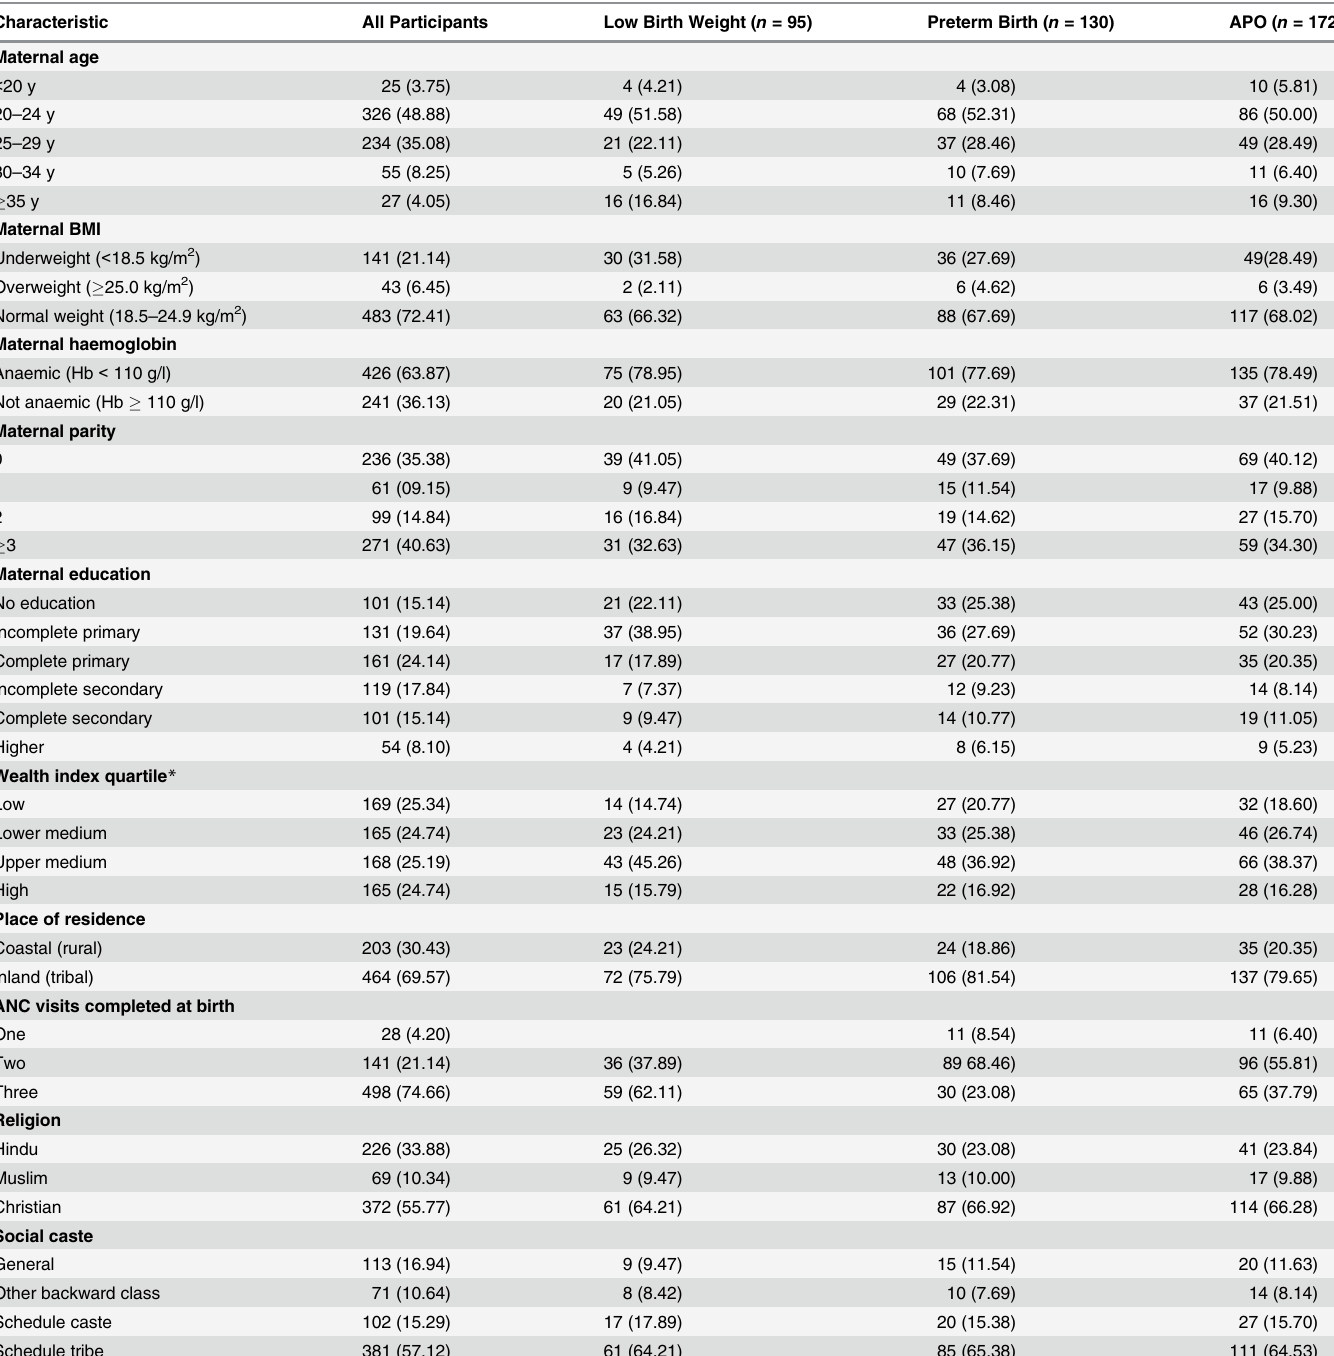
Table 1. Pregnant women ’ s selected socio-demographic, anthropometrics, and clinical characteristics stratified by adverse pregnancy outcome ( n =